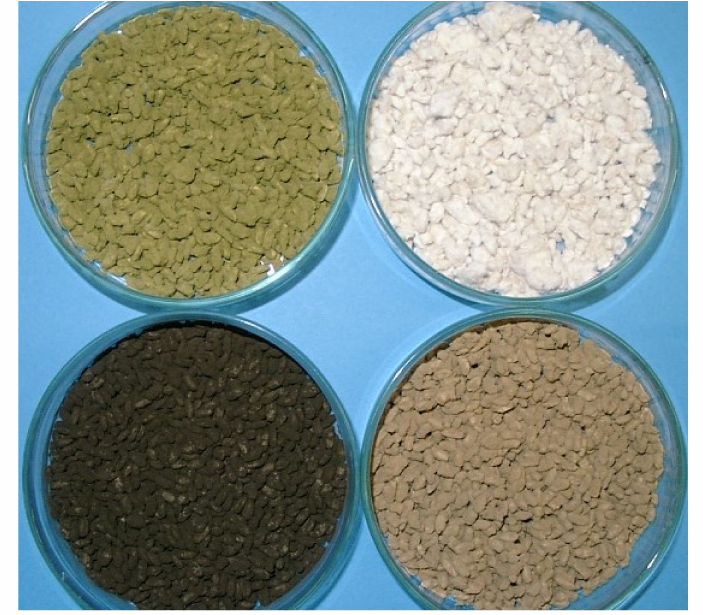
Figure 2. Color mutant of koji mold: upper image— Aspergillus oryzae ; lower image— Aspergillus luchuensis